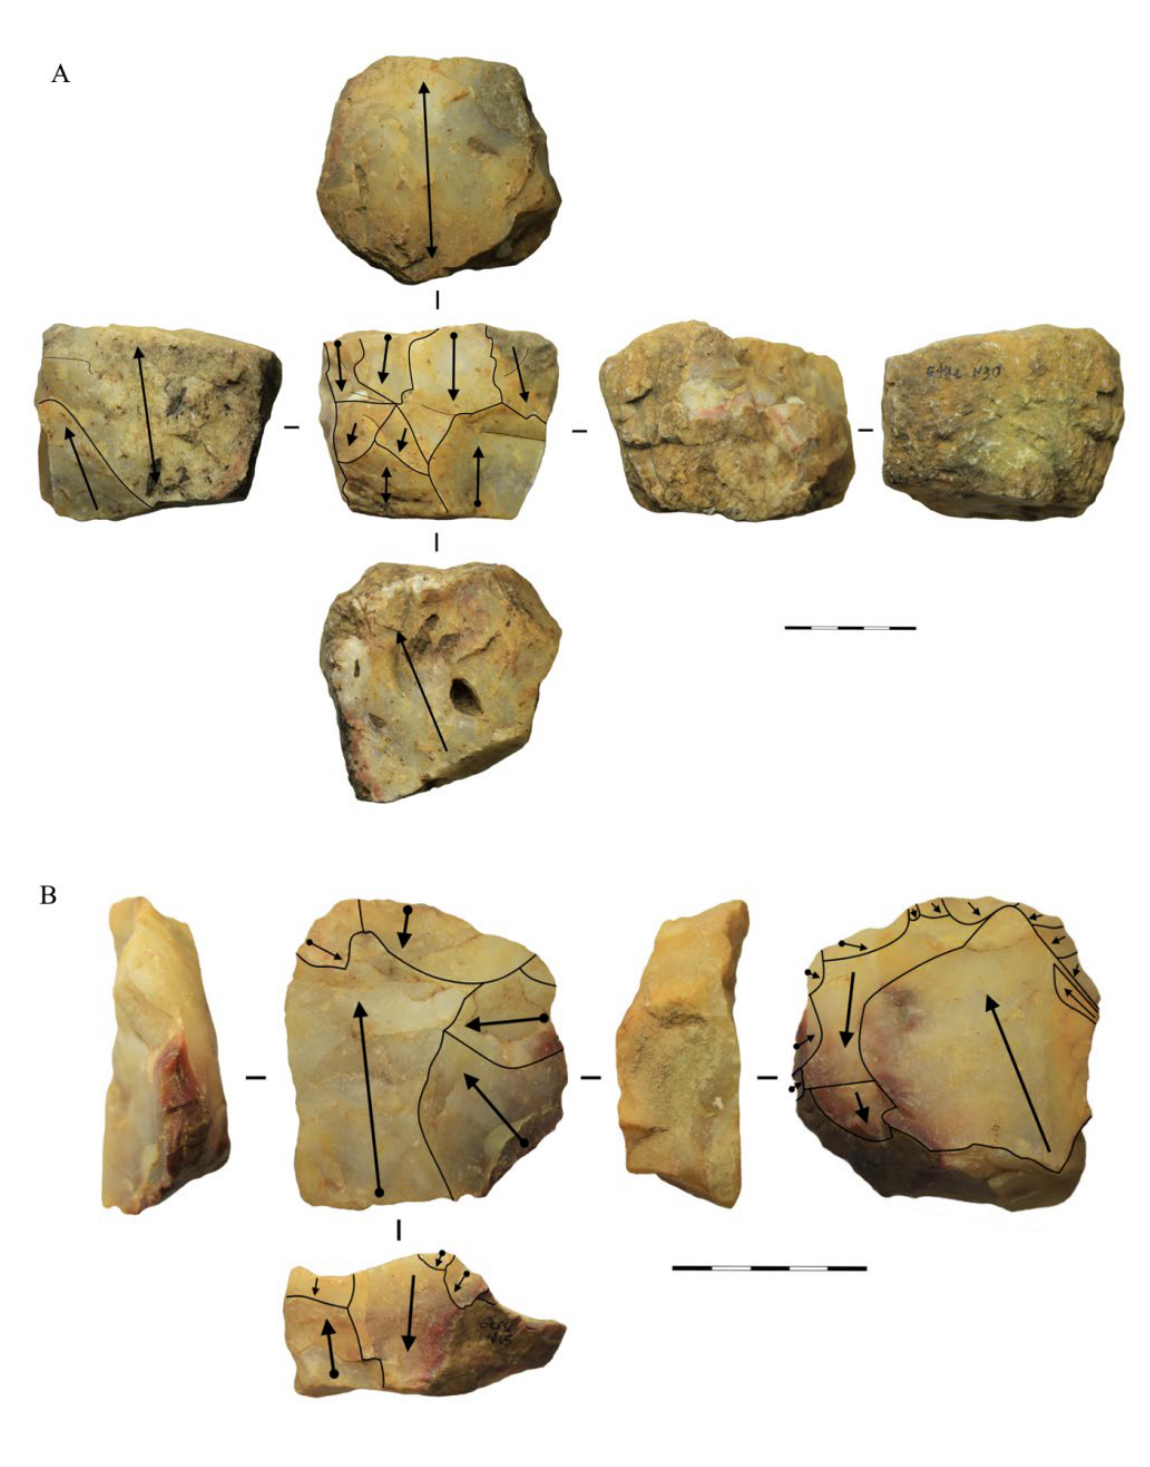
Figure 7. Cores from Les Geissières. A: bipolar-on-anvil on a small portion of good quality raw material. B: Levallois exploitation on a very good quality quartzite pebble. Scale bar: 5